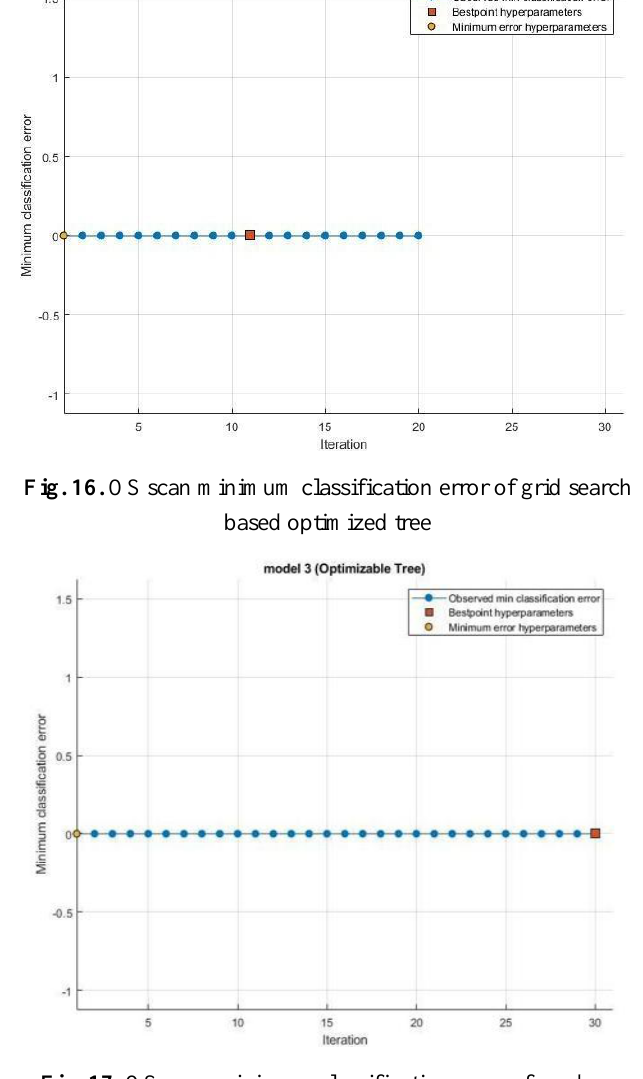
Fig. 14. Fuzzing minimum classification error of random search based optimized tree